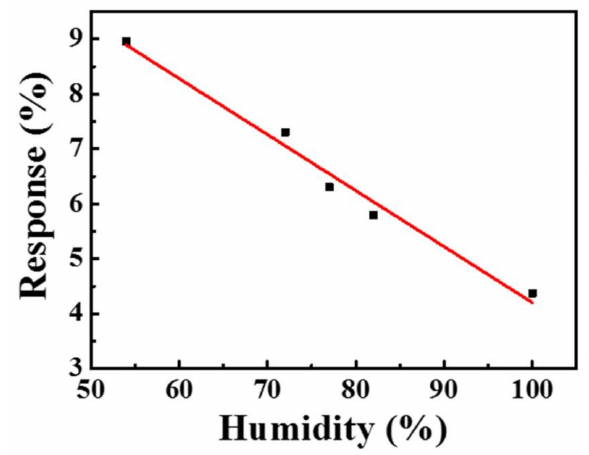
Figure 14. The response of the gas sensor to 1 ppm NO 2 at 150 ◦ C under a humidity effect.